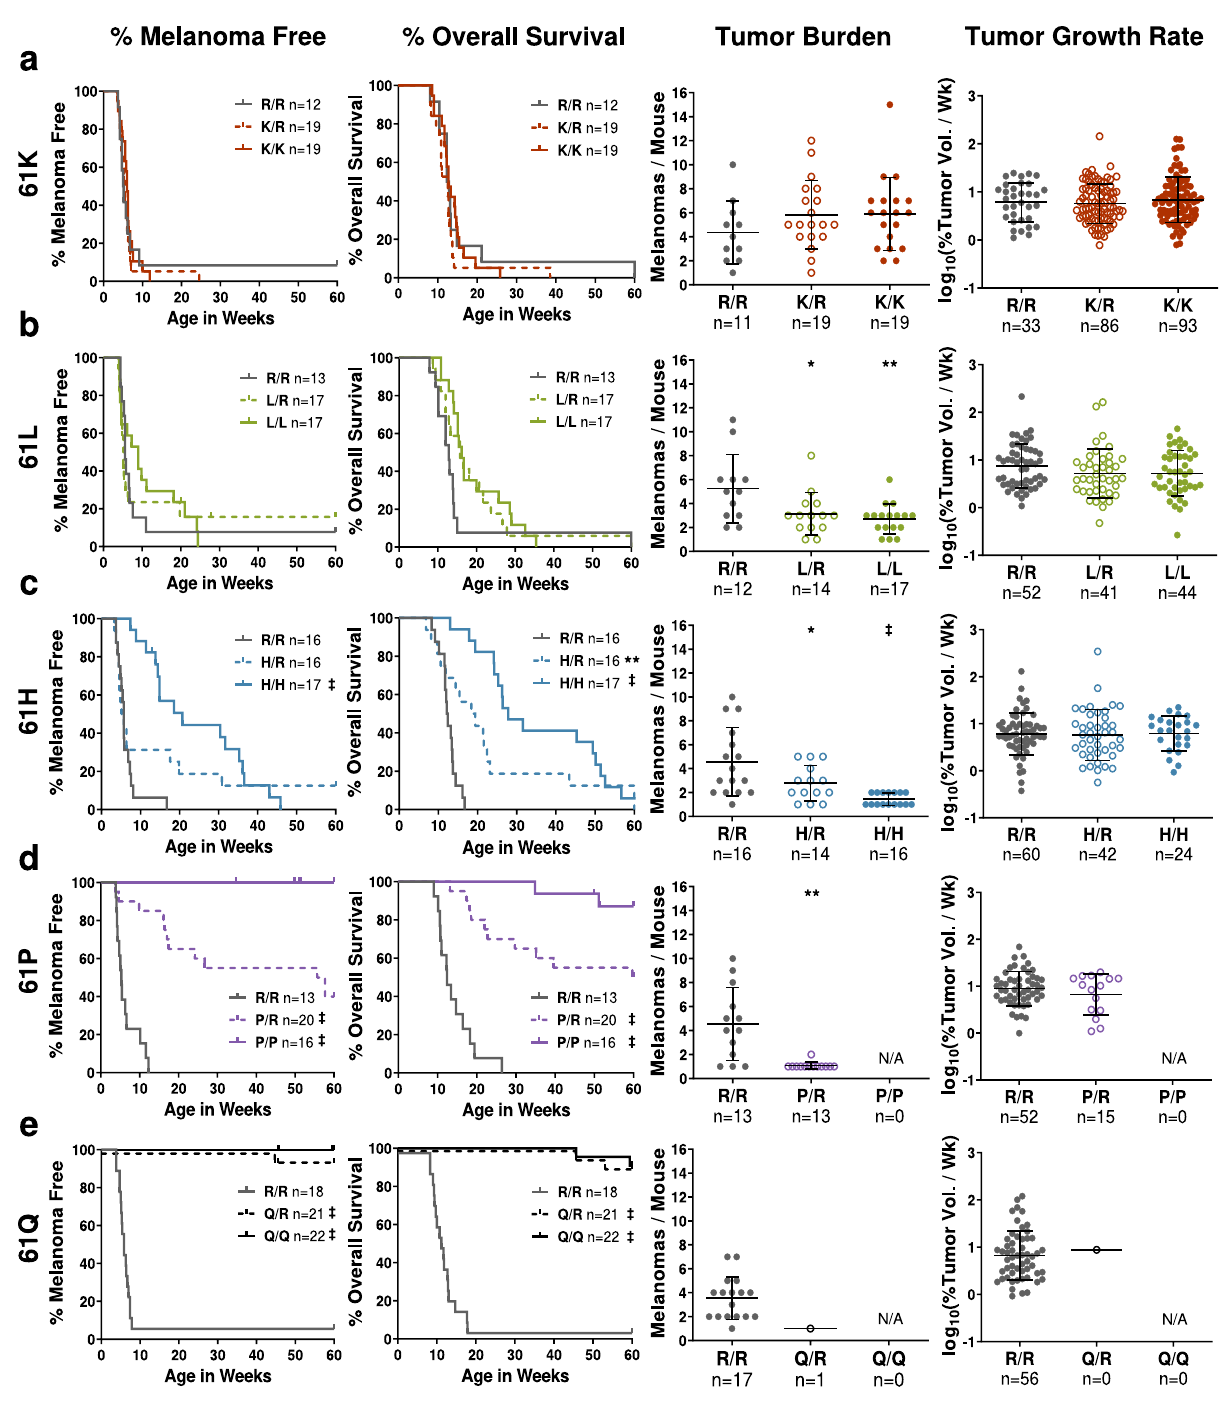
Fig. 2 Combining codon 61 mutants defective in GTPase activity results in an intermediate melanoma phenotype. Melanoma-free survival, overall survival, tumor burden, and tumor growth rates for the following treatment cohorts: a TN 61K/R , b TN 61L/R , c TN 61H/R , d TN 61P/R , and e TN 61Q/R . Tumor burden and growth rate dot plots are presented as mean values + / − SD. The following number biologically independent animals were evaluated per genotype (61K cohort: R/R = 12, K/R = 19, K/K = 19; 61L cohort: R/R = 13, L/R = 17, L/L = 17; 61H cohort: R/R = 16, H/R = 16, H/H = 17; 61P cohort: R/ R = 13, P/R = 20, P/P = 16; 61Q cohort: R/R = 18, Q/R = 21, Q/Q = 22). In a – e , the phenotype of TN 61R/R mice was compared to TN 61X/X and TN 61X/R animals. Log-rank (Mantel – Cox) tests were used to compare survival. One-way ANOVA with a Dunnet T3 multiple comparisons test was used to compare tumor burden and growth between each genotype and TN 61R/R for that cohort. Adjusted p -values for all comparisons can be found in Supplementary Table 1f. * p < 0.05, ** p < 0.01, ‡ p < 0.0001. Source data are provided as a Source Data fi